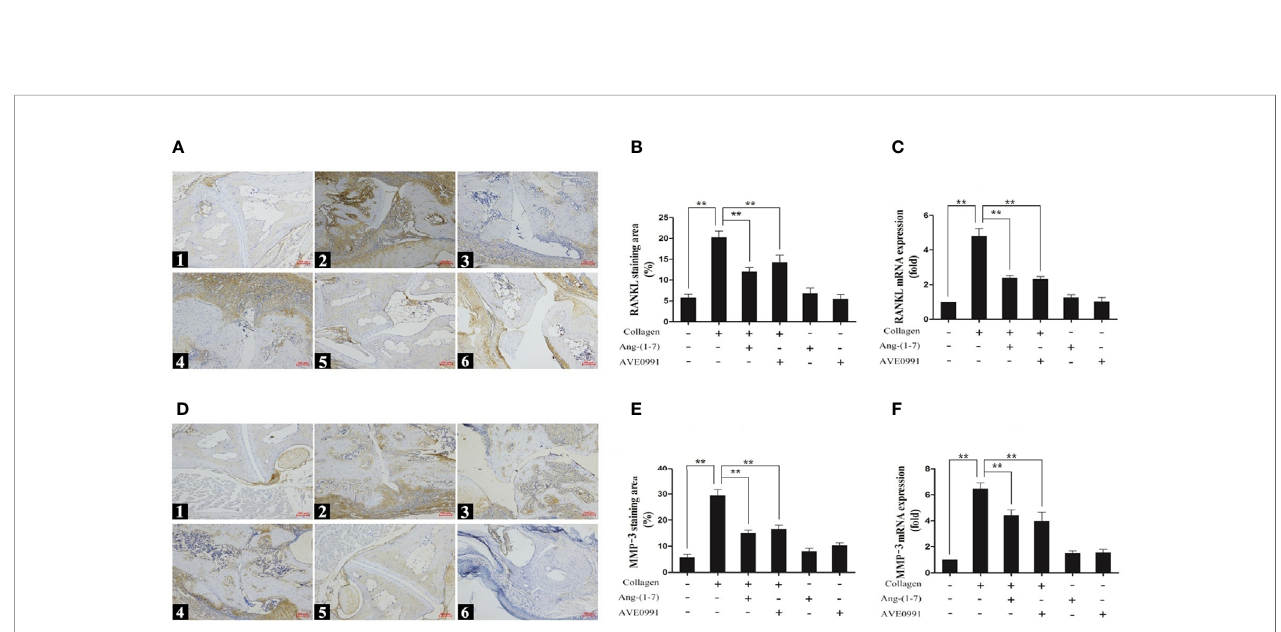
FIGURE 5 | Immunohistochemical staining and nucleic acid expression of RANKL and MMP-3 in ankle. (A1, D1) Control group, (A2, D2) CIA group, (A3, D3) CIA + Ang-(1 – 7) group, (A4, D4) CIA + AVE0991 group, (A5, D5) Ang-(1 – 7) group, (A6, D6) AVE0991 group. Magni fi cation = 100× (A, D) . (B) Quanti fi cation of RANKL staining evaluated with Image-Pro Plus v 6.0. (E) Quanti fi cation of MMP-3 staining evaluated with Image-Pro Plus v 6.0. The mRNA expression of (C) RANKL and (F) MMP-3 was detected by real-time PCR. Relative gene expression was calculated using the 2 ¯ △△ CT method; the GAPDH gene served as the internal control. Values are expressed as means ± SD (n = 6), **P <